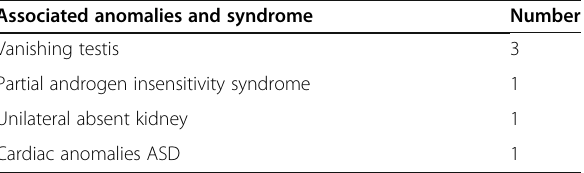
Table 5 Associated anomalies and syndrome detected with epididymal and vas deferens anomalies in cases of